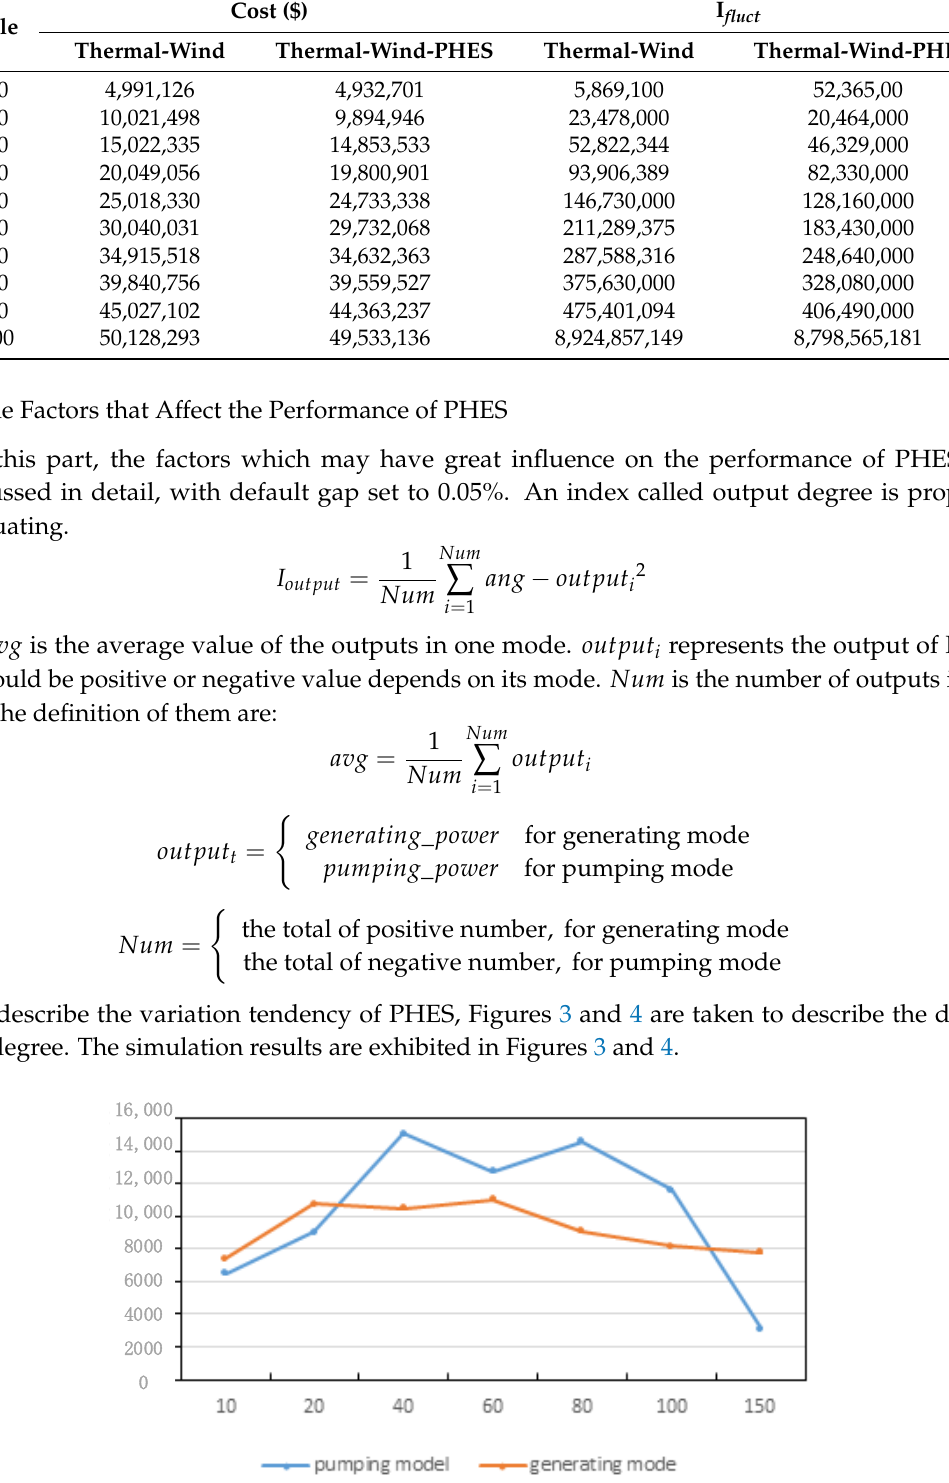
Figure 3. Comparison of PHES in different scale of systems.